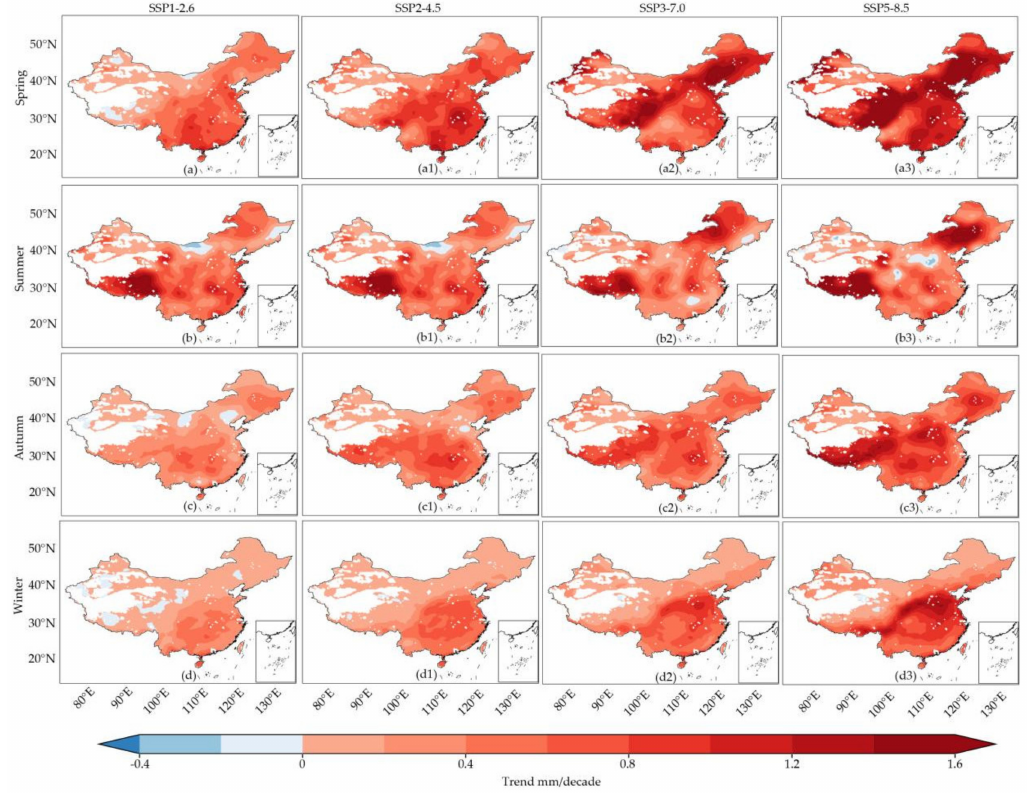
Figure 6. The seasonal trend of future LET change from 2021 to 2100 in different scenarios; ( a – d ) correspond to spring, summer, autumn and winter, respectively. The ( a ), ( a1 ), ( a2 ) and ( a3 ) correspond to the future spring change in SSP1–2.6, SSP2–4.5, SSP3–7.0 and SSP5–8.5. The ( b ), ( b1 ), ( b2 ) and ( b3 ) correspond to the future summer change in SSP1–2.6, SSP2–4.5, SSP3–7.0 and SSP5–8.5. The ( c ), ( c1 ), ( c2 ) and ( c3 ) correspond to the future autumn change in SSP1–2.6, SSP2–4.5, SSP3–7.0 and SSP5–8.5. The ( d ), ( d1 ), ( d2 ) and ( d3 ) correspond to the future winter change in SSP1–2.6, SSP2–4.5, SSP3–7.0 and